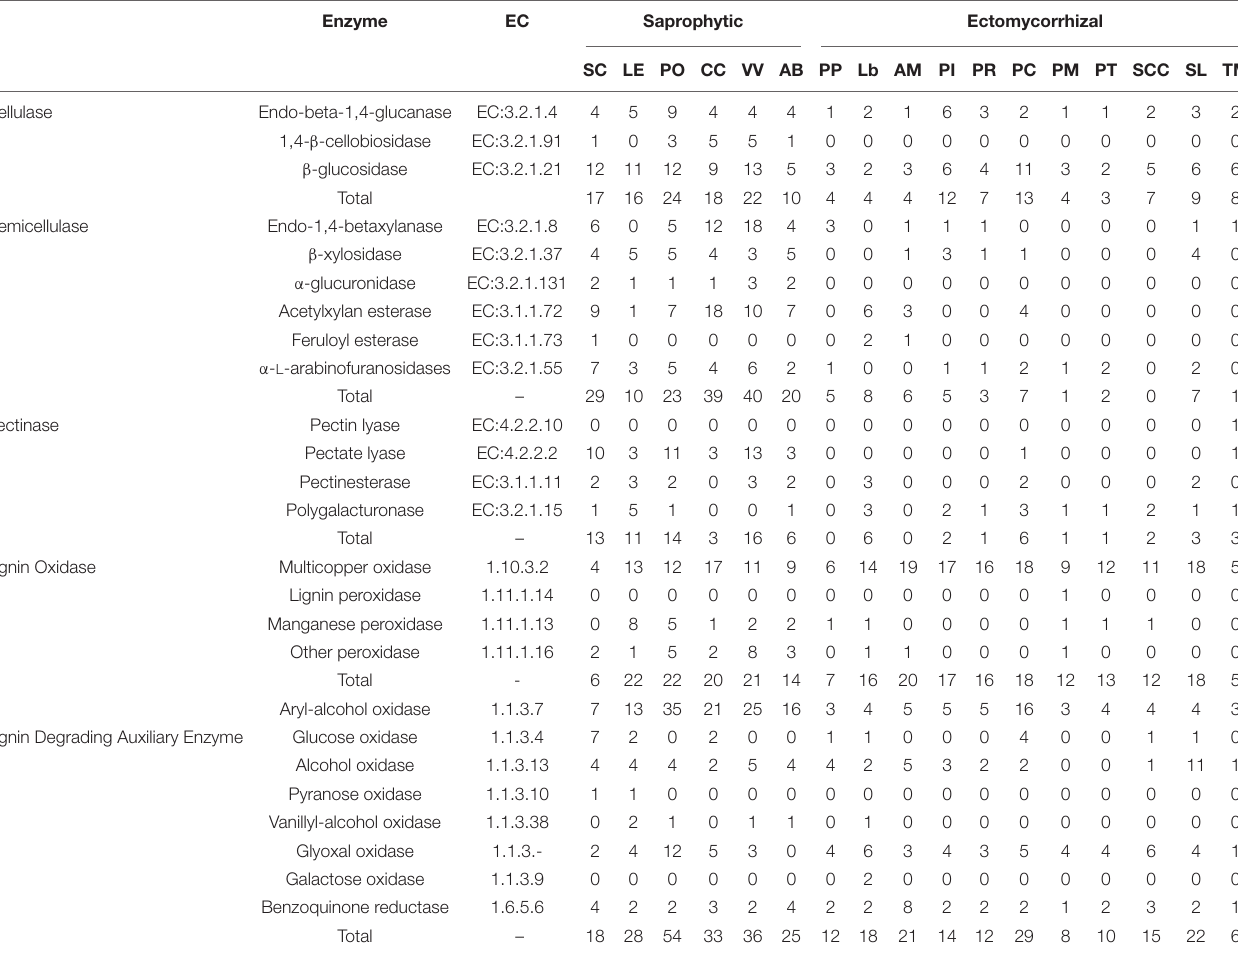
FIGURE 1 | Heatmap clustering of mycorrhizal and saprophytic fungi based on genes related to CAZyme families and lignocellulose decomposition. (A) Heatmap clustering based on CAZyme families; (B) Heatmap clustering based on genes related to lignocellulose decomposition.